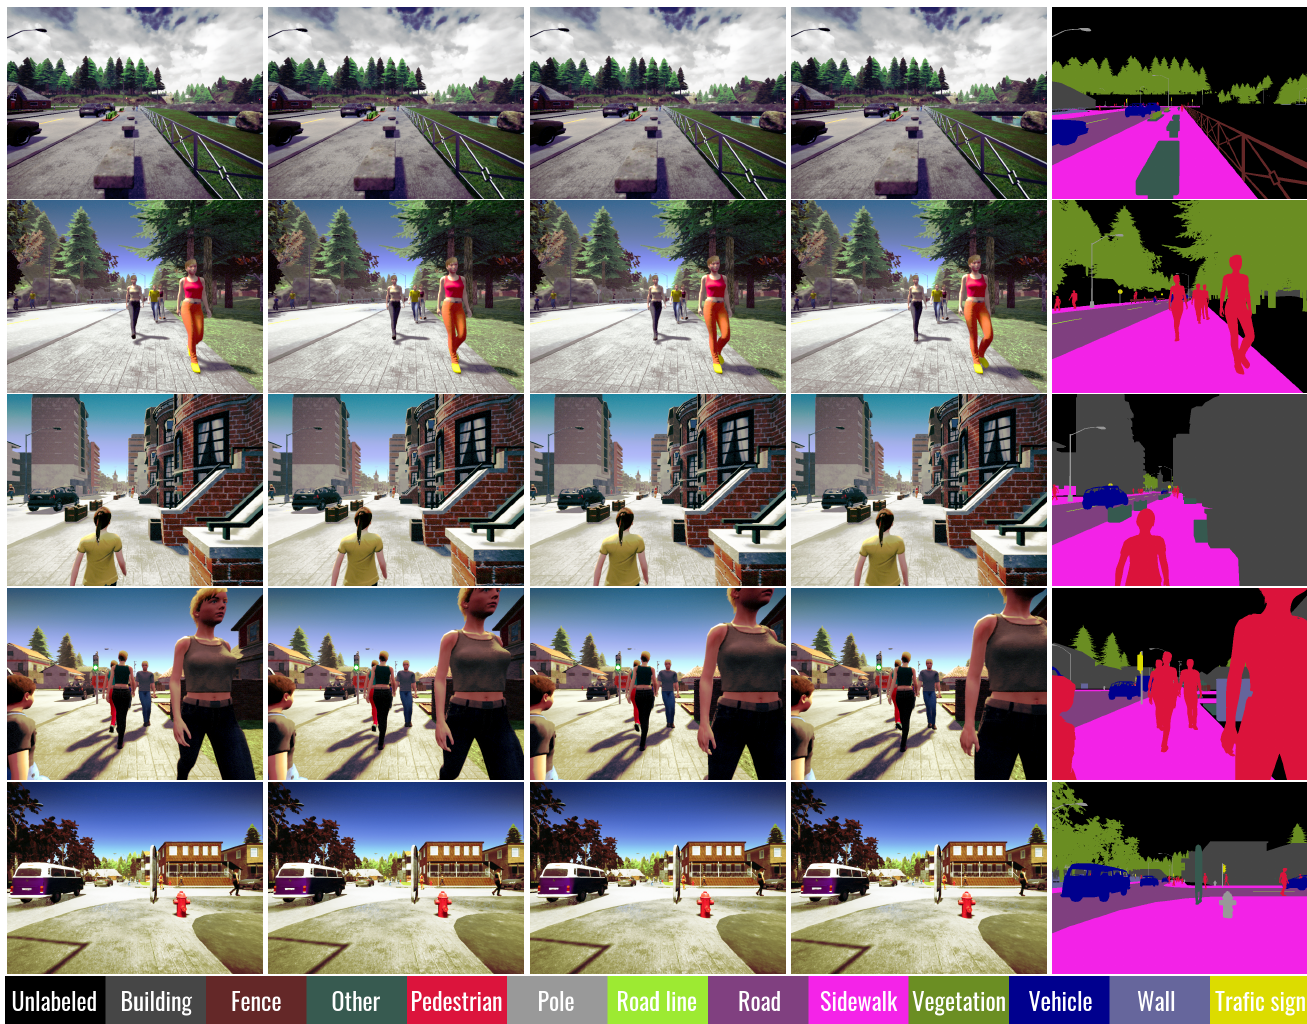
Figure 1. Examples of image sequences from the dataset. Each sequence is made of 4 images with a small gap between each. The column of images at the right is made of the ground-truth corresponding to the last RGB image of each